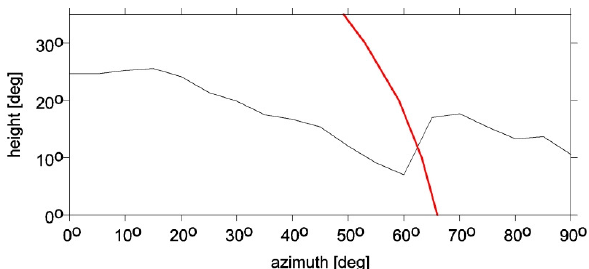
Figure 9: The terrain profile with observation point on the pyramid (point P) in direction north to east for sunrise at winter